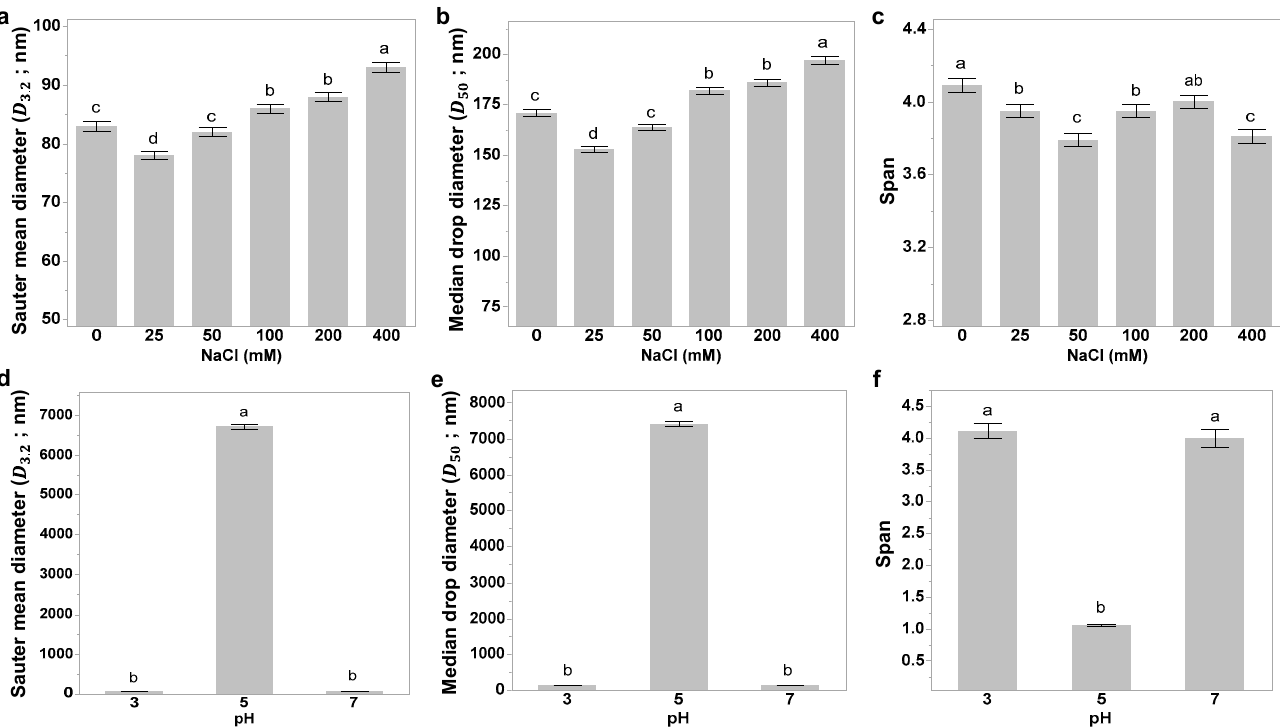
Figure 4. Emulsion characteristics (Sauter mean diameter, median droplet diameter, and span) of pea protein isolate-stabilized nanoemulsions at different NaCl solutions ( a – c ) and at different pH conditions ( d – f ). Different alphabets above the error bars indicate significant difference among sample means at p < 0.05.